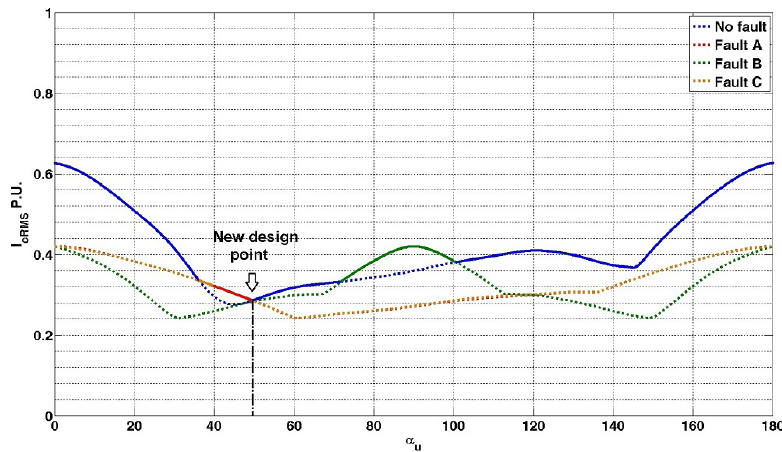
Figure 14. Simulated results: triple-3-phase machine: I C combinations including in fault conditions.